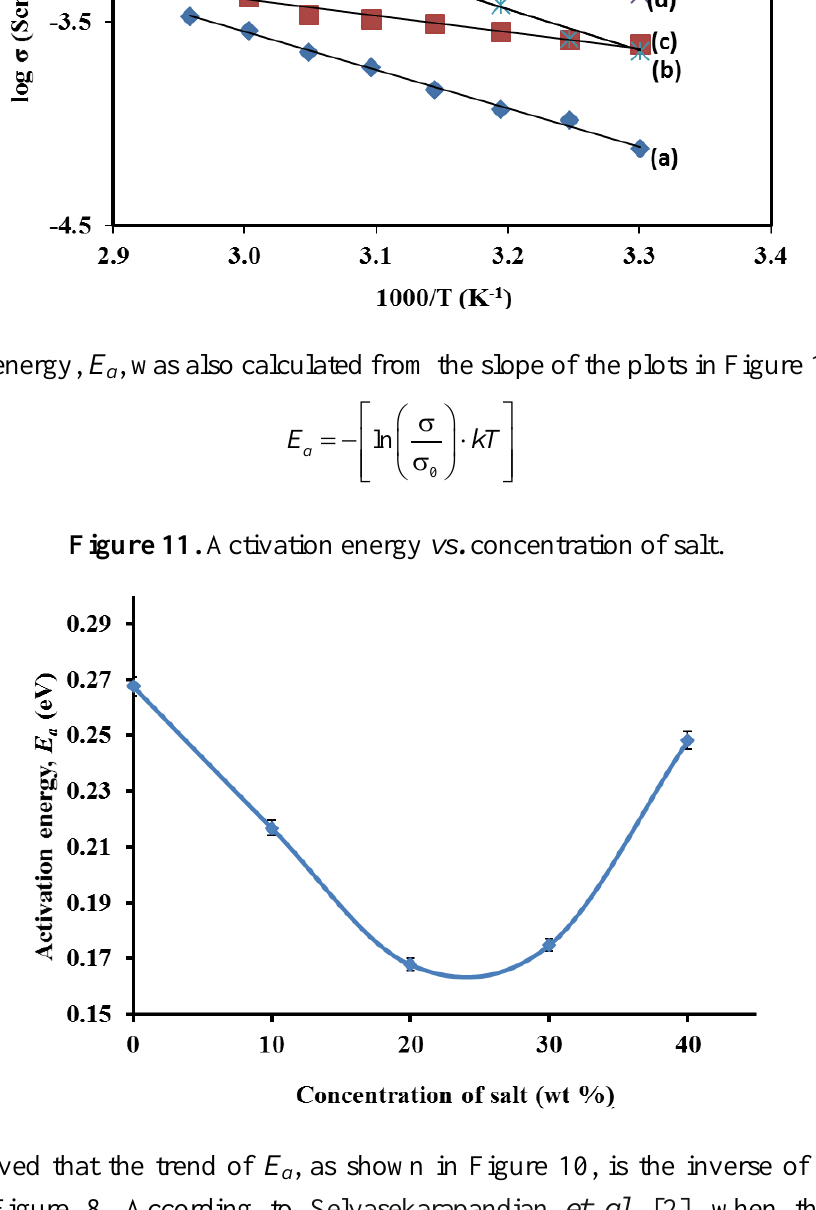
COONH ; ( d ) 30 wt% of CH 3 4